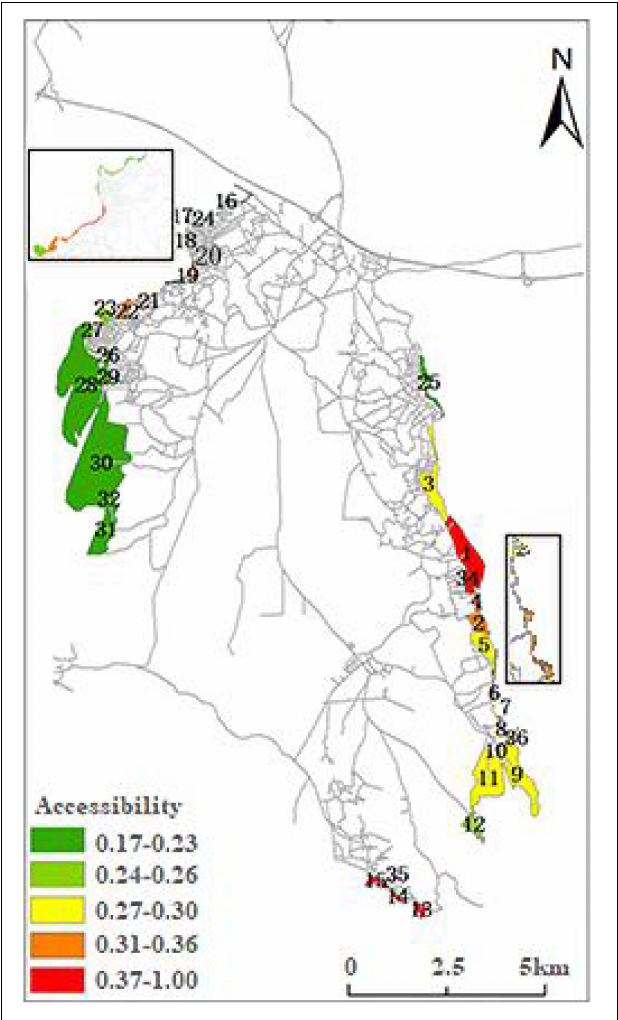
FIGURE 10 | Accessibility calculated by